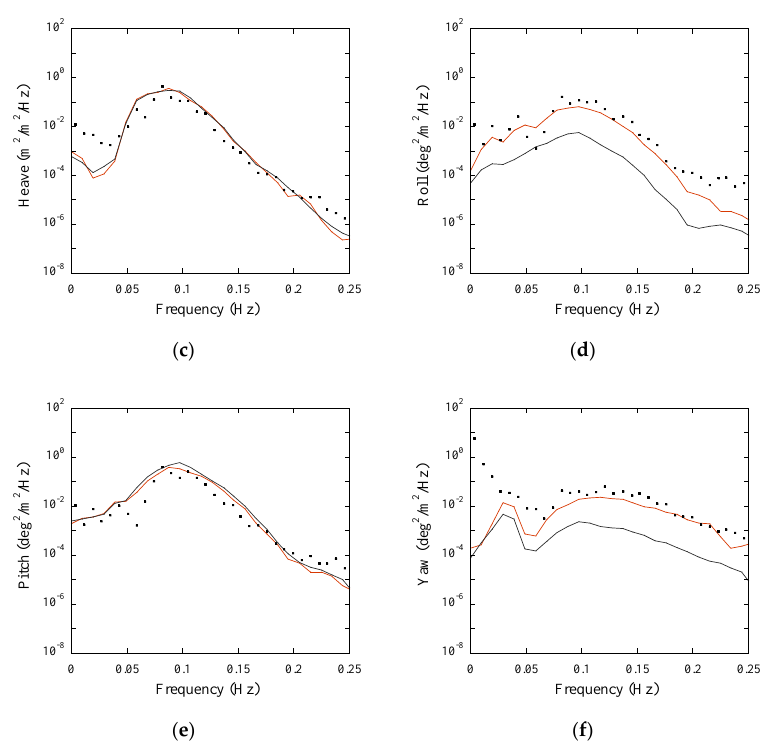
Figure 17. Normalized PSD of observed and simulated motions in the six degrees of freedom at the low wave height case. ( a ) PSD of surge motion, ( b ) PSD of sway motion, ( c ) PSD of heave motion, ( d ) PSD of roll motion, ( e ) PSD of pitch motion and ( f ) PSD of yaw motion. Energies 2020 , 13 , x FOR PEER REVIEW